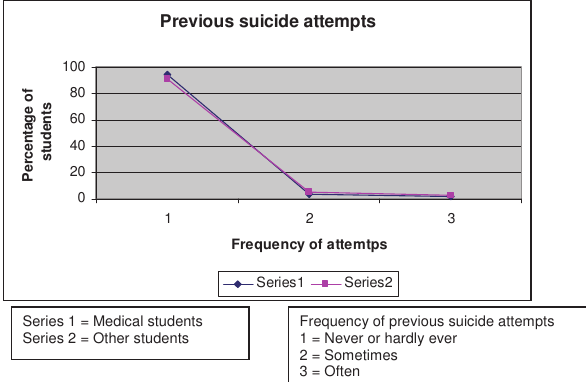
Fig. 4. Subjective feelings of hopelessness.